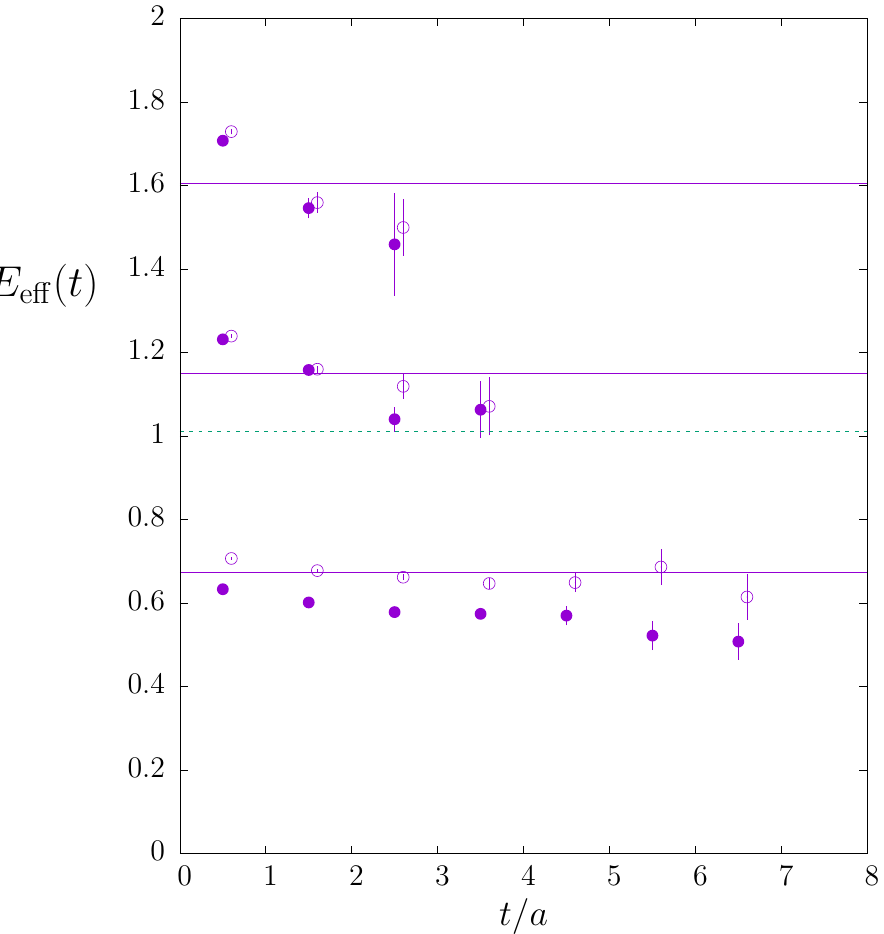
Figure 2 . Effective energies of the lightest 3 states from our ditorelon basis of operators for the A 1 ++ , • , and E ++ , ◦ , representations. On a 18 3 26 lattice at β = 6 . 235 . Horizontal lines are estimated energies of lightest ditorelon states neglecting interactions between the torelons; dashed line for the lightest tritorelon